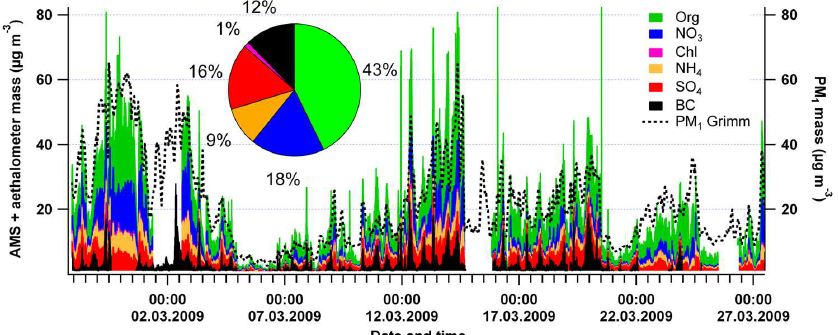
Fig. 1. Stacked time series of AMS species (Org, NO 3 , NH 4 , SO 4 , and Chl), BC measured by the aethalometer. PM 1 data from the Grimm laser-spectrometer (corrected using PM 1 samples collected on filters) are plotted on the right axis. The pie chart shows the campaign averagerelative contributions of AMS species and BC to PM1 (campaign average concentration: 18.5µgm − 3